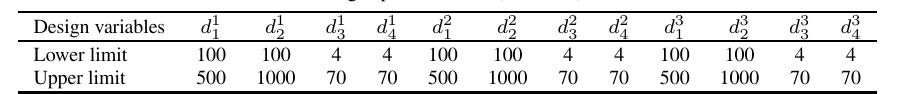
Table 1 Design space of frame (unit: